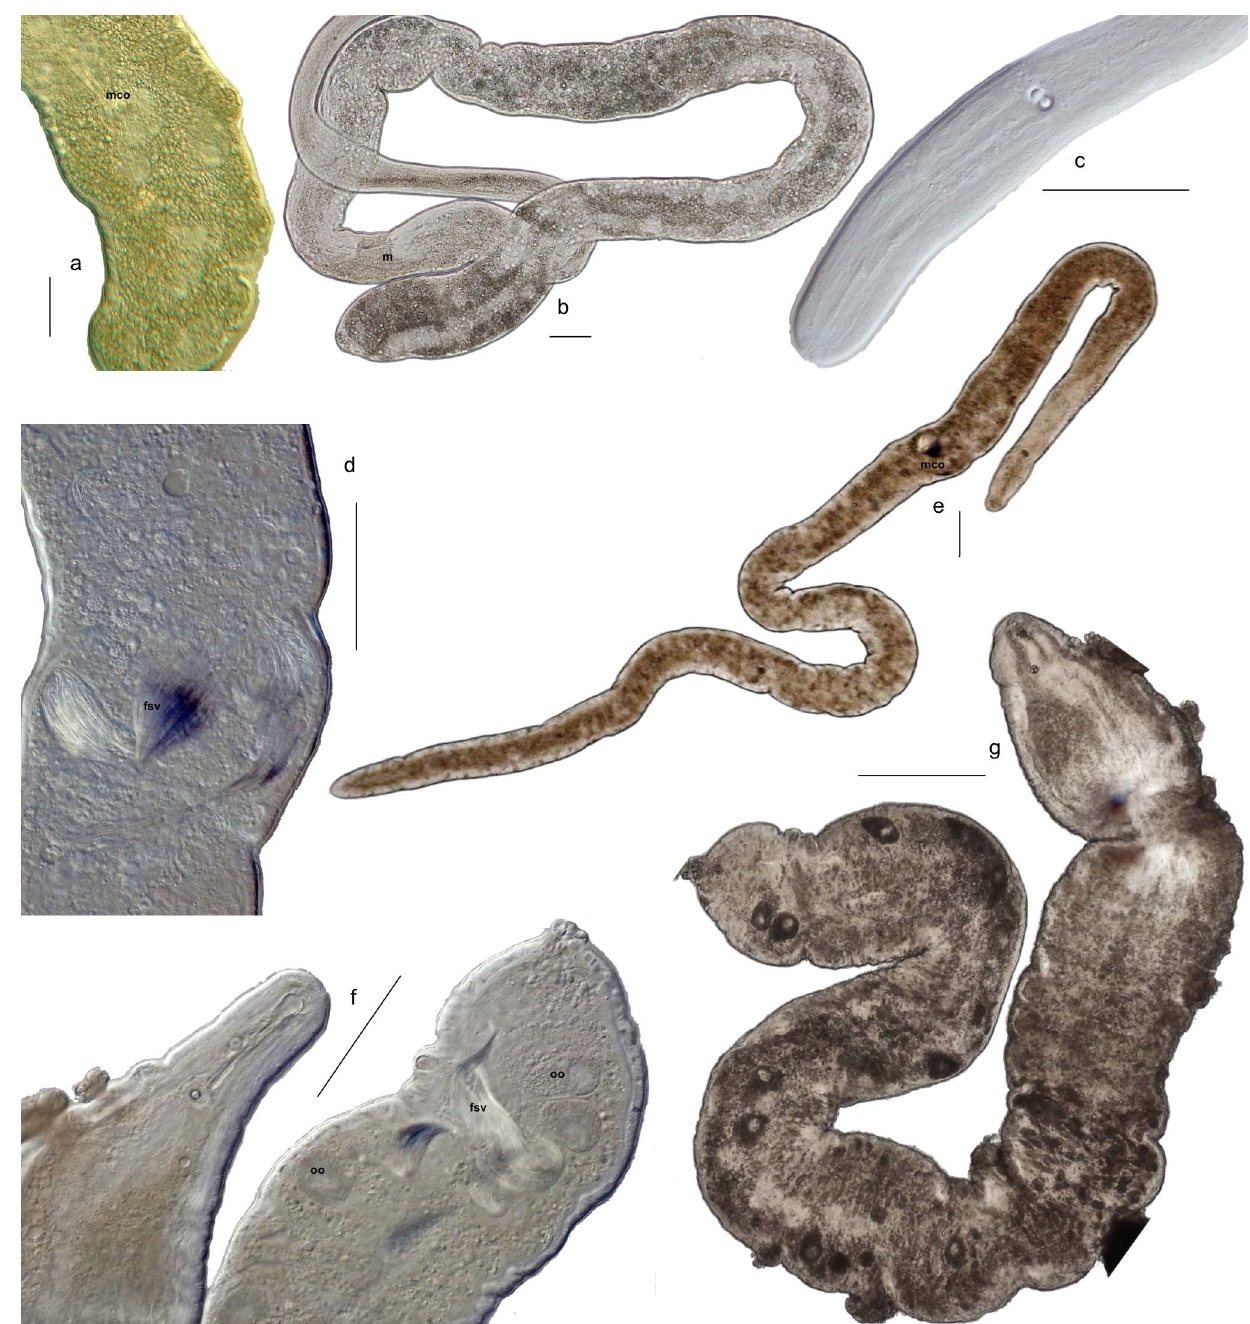
Figure 6. Diversity within the genus Nemertinoides . a–c: Nemertinoides glandulosum n.sp. a) Posterior with mco. b) Overview (anterior region missing) of worm with mouth (m). c) Anterior with statocyst with double statoliths and frontal organ. d, e: Nemertinoides elongatus . d) Detail of the male copulatory organ with false seminal vesicle. e) Overview of whole animal with position of the mco. f, g: Nemertinoides wolfgangi n.sp. f) Anterior and posterior of fully mature animal with oocytes and fsv in the posterior. Only one statoliths in statocyst visible as photo is taken slightly laterally. g) Overview over the same animal with oocutes still visible but no fsv. Photographs were taken of live specimens, b–g are photographs of the respective holotypes. The scale bars indicate 100 m m for each photograph. Statocyst more posterior than in Nemertinoides . Mouth ventral at U50. Paired testes follicular. Male pore opens dorsally at U90, fsv anterior to that. Paired ovaries anterior of mco; oocytes mature caudad.